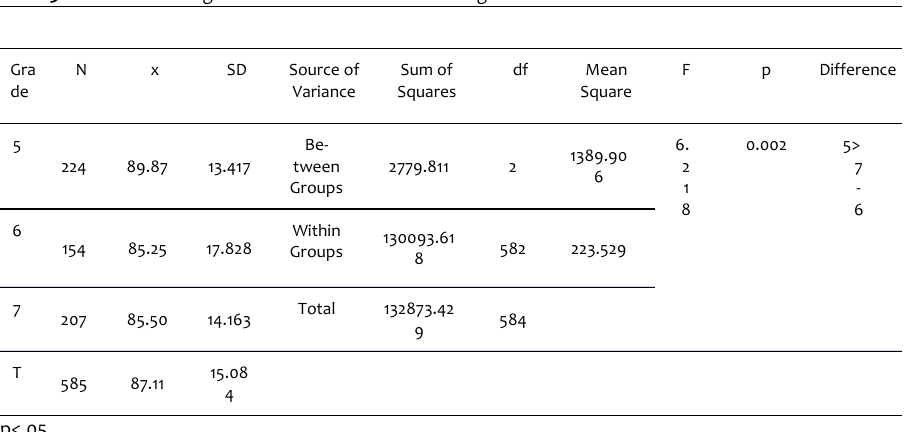
Table 3. Students' reading motivation scores in relation to grade level